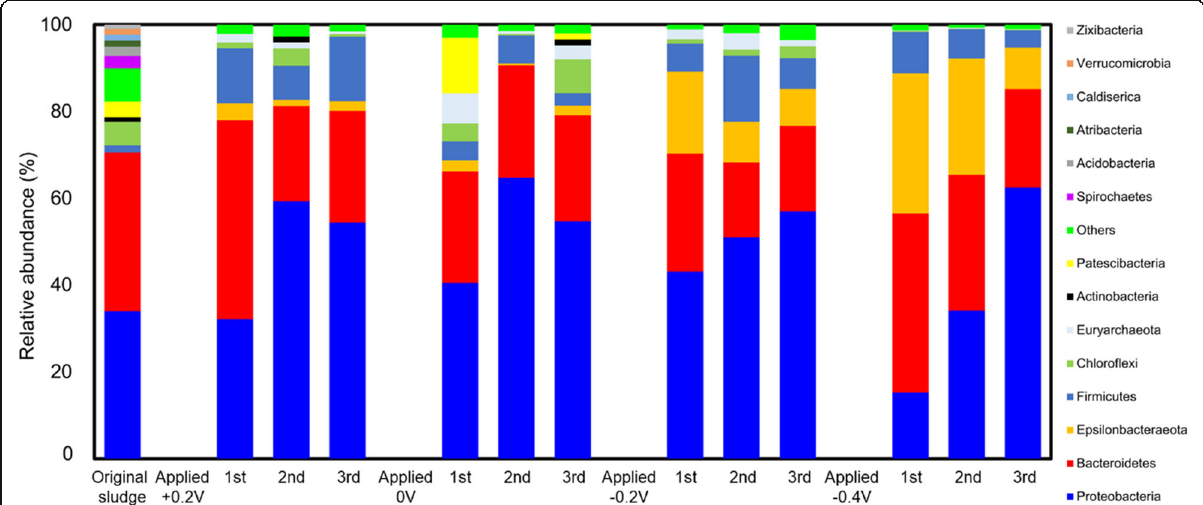
Fig. 2 Relative abundance of different phyla on original sludge and anodes cultivated at poised potential sampled from three substages (1 st sampling at substage 1, 2 nd sampling at substage 2, 3 rd sampling at substage 3). Unassigned and minor phyla accounting for < 1% of total